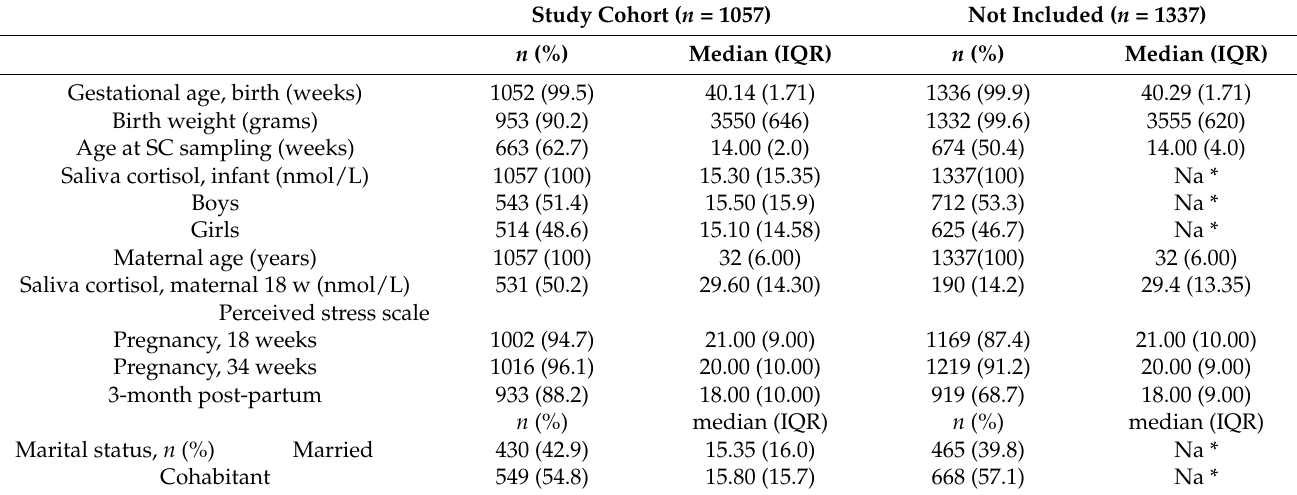
Table 1. Maternal, neonatal and infant characteristics of the infants with saliva cortisol at three months of age ( n = 1057) and for those that did not provide saliva samples (not included n = 1337). Values are presented as numbers, percent (%), median iSC, interquartile range (IQR). Study Cohort ( n = 1057) Not Included ( n =